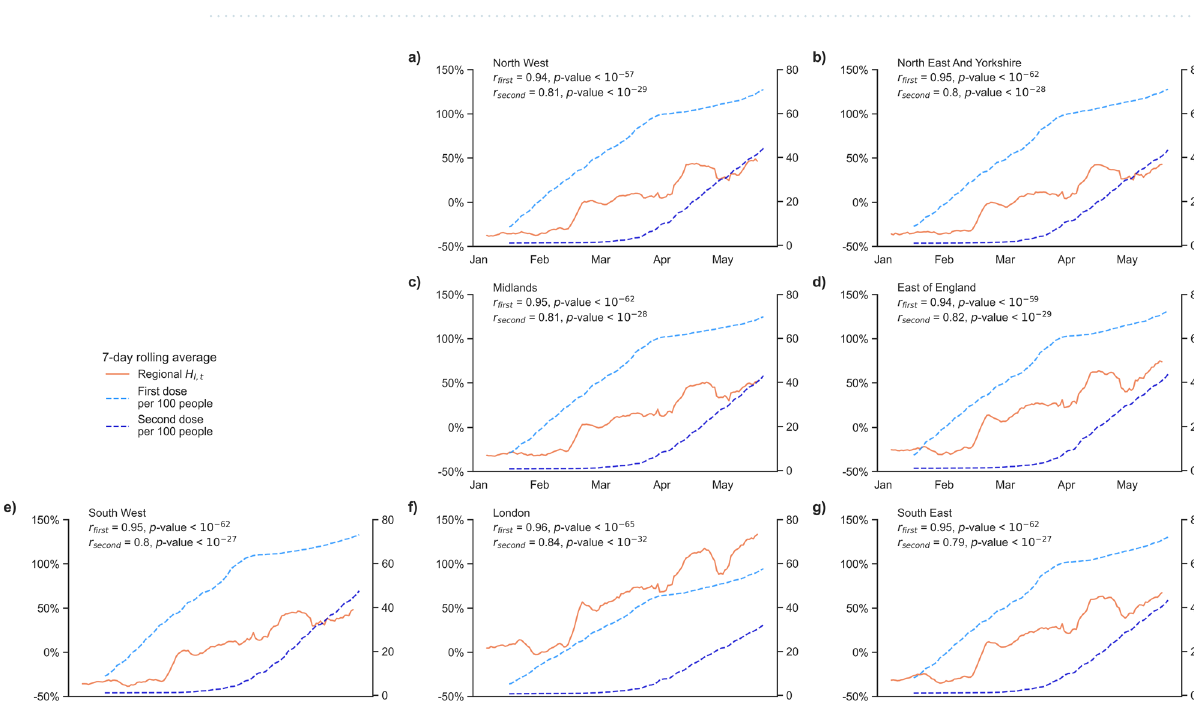
Figure 5. Change in H l , t in England regions from January 2021 with number per 100 people who received first or second dose of COVID-19 vaccine. ( a–g ) , data on vaccinations has been released at the scale of UK regions since mid-January. Significant positive correlations are observed for all regions between regional H l , t and number of first dose or second dose of house visitation rate, that is consistent across all regions of the UK. The increases in household visits are shown at a time where indoor household mixing was heavily restricted, and only relaxed on 17th May 2021.